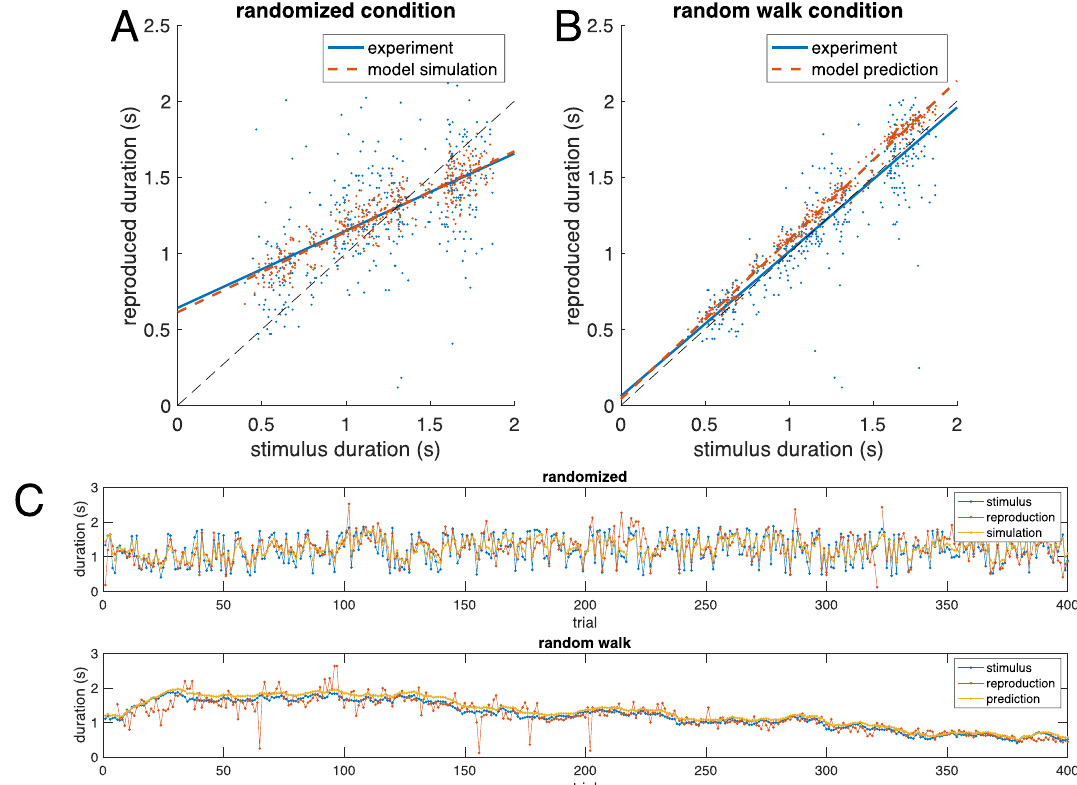
Figure 7. Example data from one participant and model results. ( A ) Data (blue) and model simulation (best fit to two-state model, red) for the ‘randomized’ condition of the duration reproduction experiment. Same data as in Fig. 4A. Lines are linear least squares fits to the data showing that the model replicates the central tendency. ( B ) Data (blue) and model prediction (red, model and parameters same as in A ) for the ‘random walk’ condition, in which successive stimuli were similar. It can clearly be seen that in this subject the central tendency dramatically changed, which was predicted by the model. ( C ) Data from A and B plotted over trial. The same stimuli were used in both conditions.